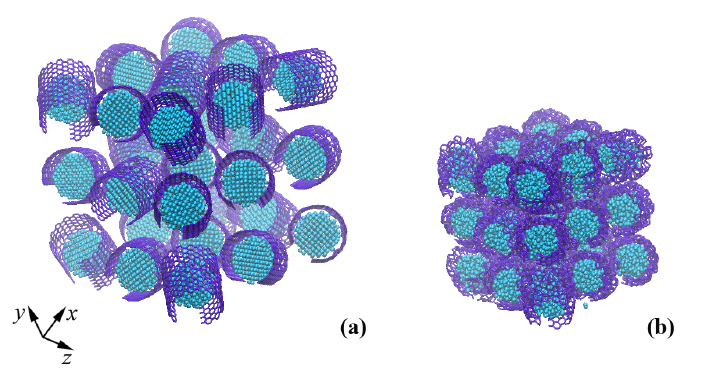
Figure 8. Snapshots of crumpled graphene filled with hydrogen atoms before ( a ) and after ( b ) hydrostatic compression. Colors are as in Figure